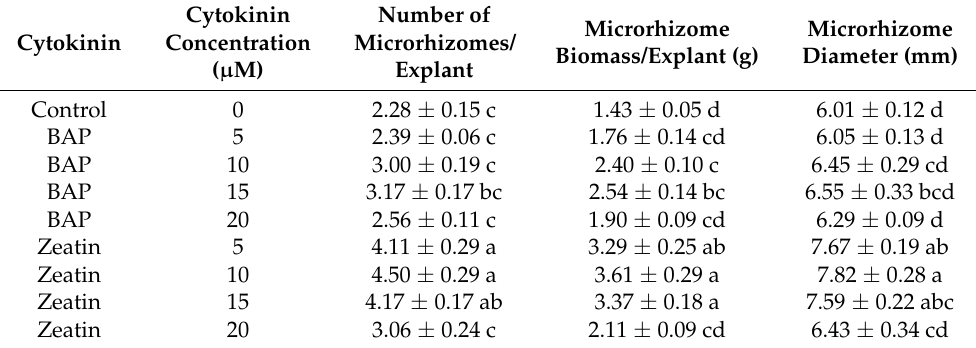
Table 1. Effects of different types and concentrations of cytokinins on microrhizome induction of Bentong ginger in MS medium supplemented with 80 g L − 1 sucrose and 2.5 µ M NAA after 14 weeks of